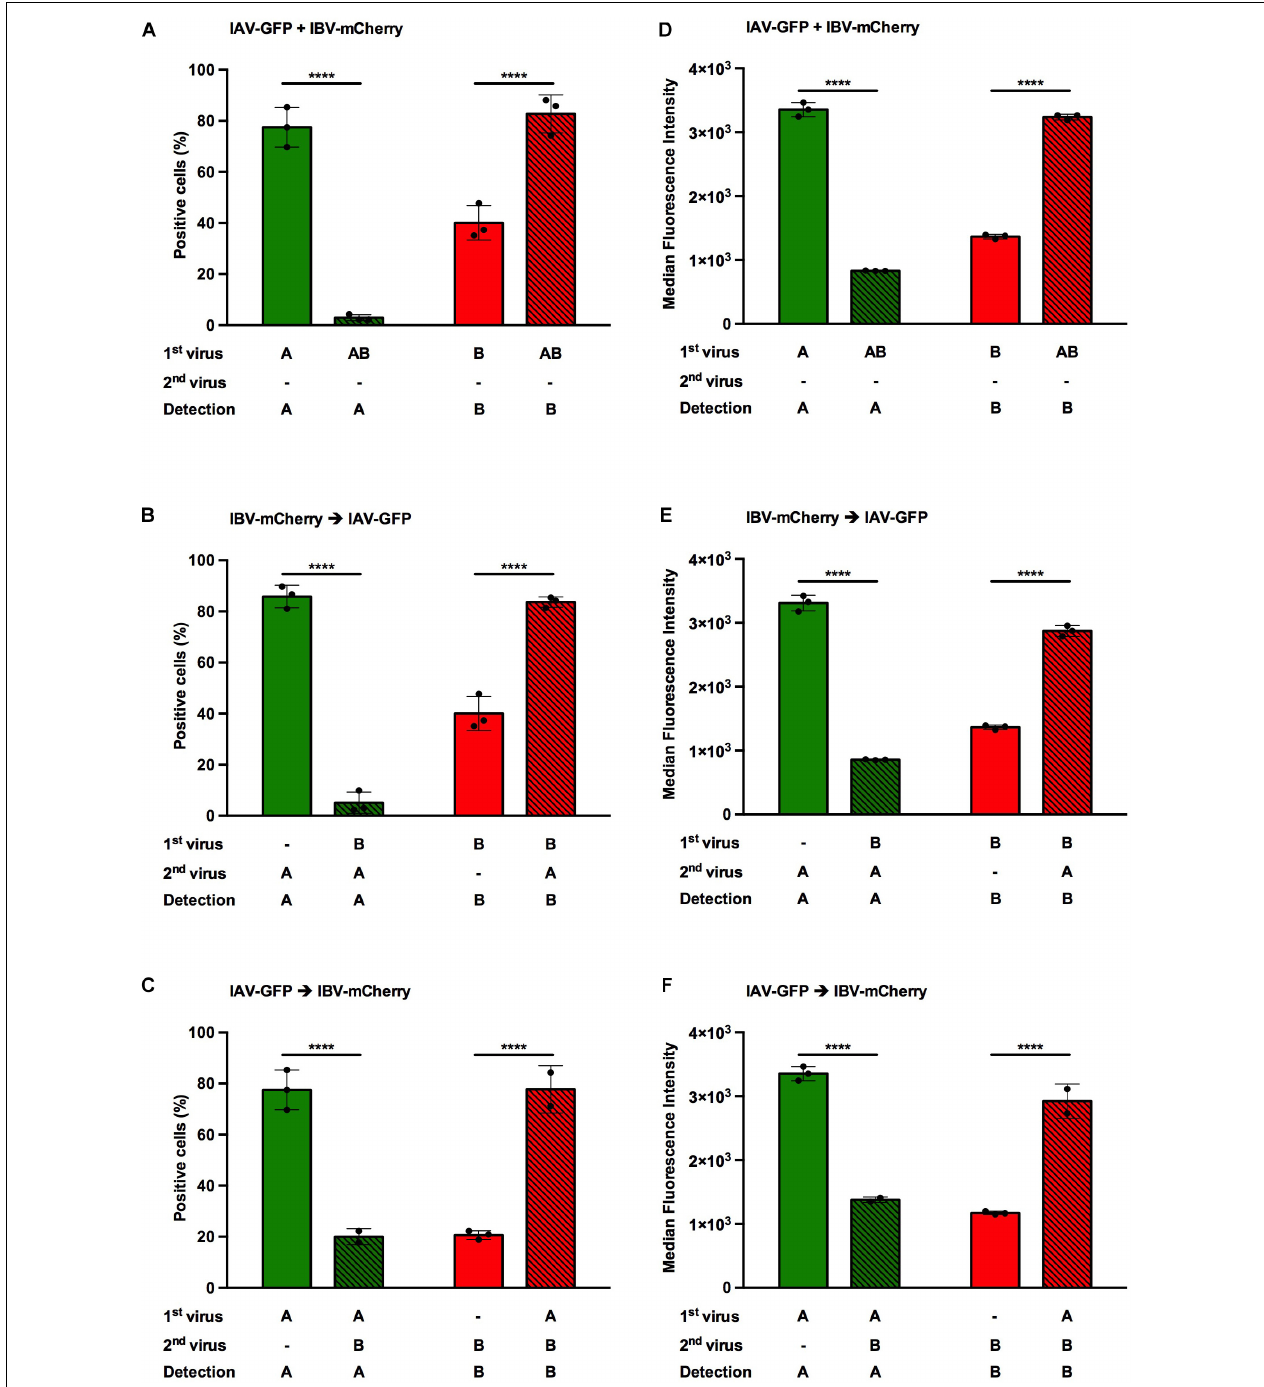
FIGURE 3 | Effect of heterotypic co-infections between IAV and IBV. A549 cells were co-infected, either simultaneously (A,D) or sequentially (B,E,C,F) , with IAV-GFP and IBV-mCherry at a MOI of 3 PFU/cell for each virus and analyzed 6 h after the addition of the last virus using flow cytometry. (A–C) The solid bars represent the proportion of fluorescent cells expressing GFP (in green) or mCherry (in red) upon control infection with IAV-GFP or IBV-mCherry alone. The hatched bars represent the proportion of fluorescent cells expressing GFP (in green) or mCherry (in red) upon co-infections. (D–F) The corresponding median fluorescence intensities are shown. (A,D) Simultaneous co-infection with IAV-GFP and IBV-mCherry viruses. (B,E) Primary infection with IBV-mCherry followed 1 hpi with IAV-GFP infection. (C,F) Primary infection with IAV-GFP followed 1 hpi with IBV-mCherry infection. One experiment representative of three independent experiments performed in triplicate is shown (see Supplementary Figure S1 ). The mean ± S.D. of biological triplicates is shown. Two-way ANOVA test: multiple comparison, Dunn-Sidak test, α = 0.05; ****: adjusted p ≤ 0.0001.